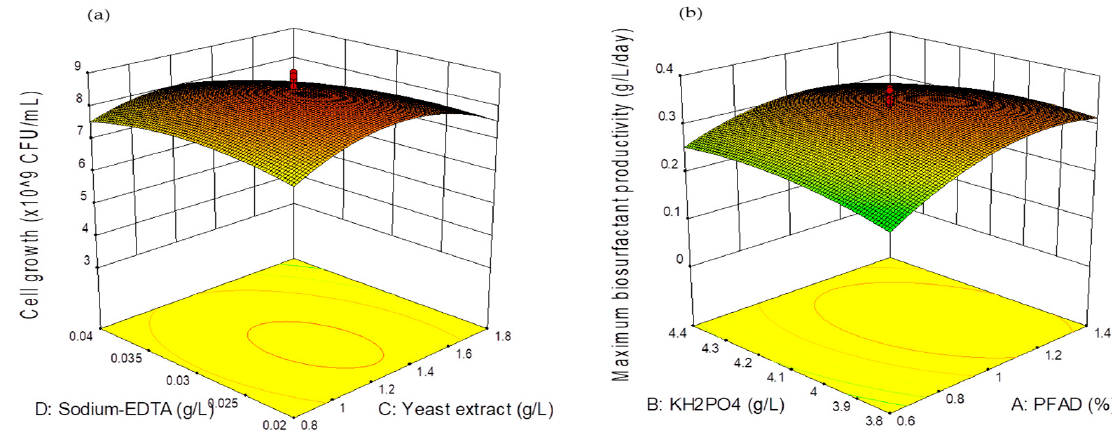
Figure 2. Response surface plot showing the interactive effect of ( a ) yeast extract and sodium-EDTA concentration on the cell growth and ( b ) KH 2 PO 4 and PFAD on maximum biosurfactant productivity.